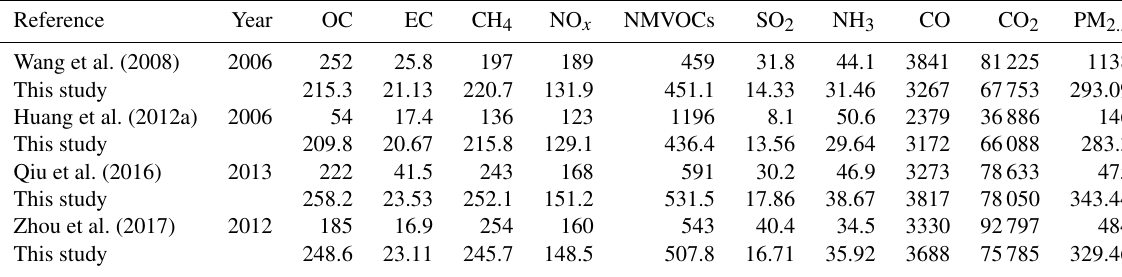
Table 8. Comparison of the emissions with previous studies in different years (Gg).